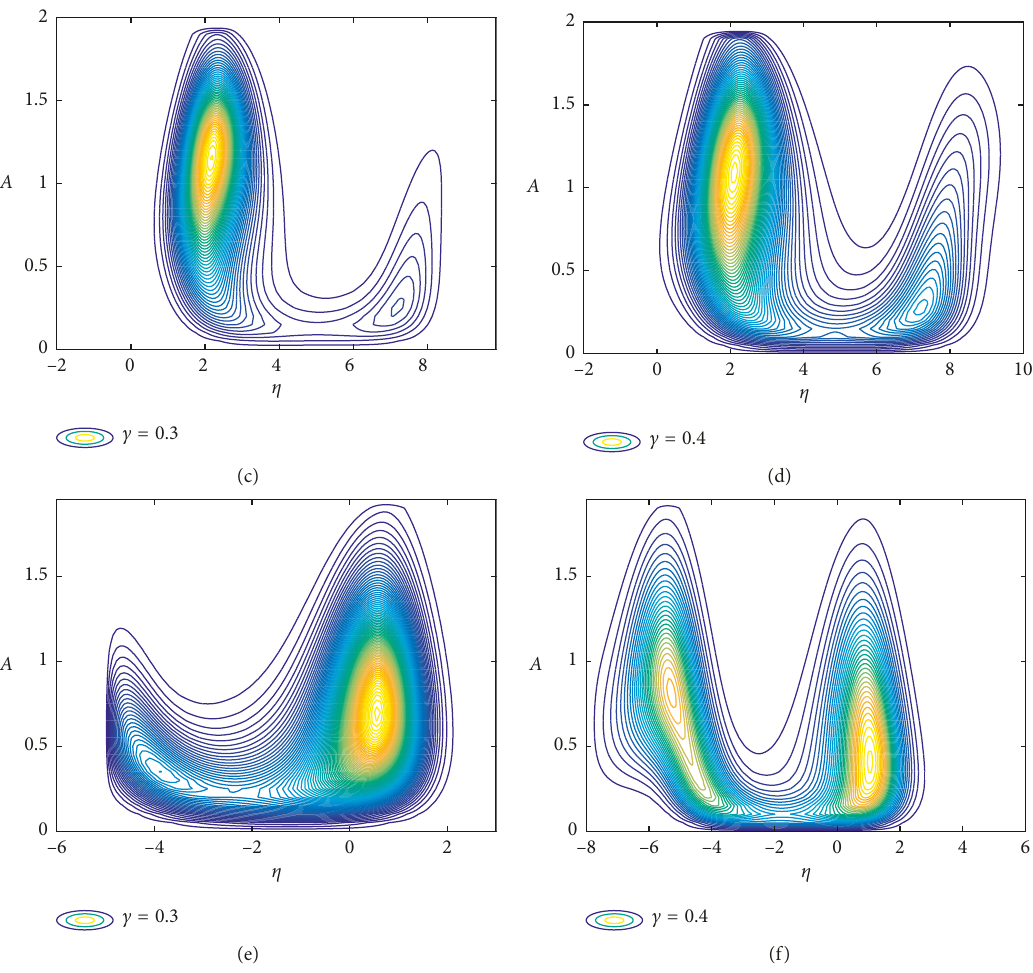
Figure 15: Contour surfaces: (a, b) pentastable energy harvester; (c, d) tristable energy harvester; (e, f) monostable energy